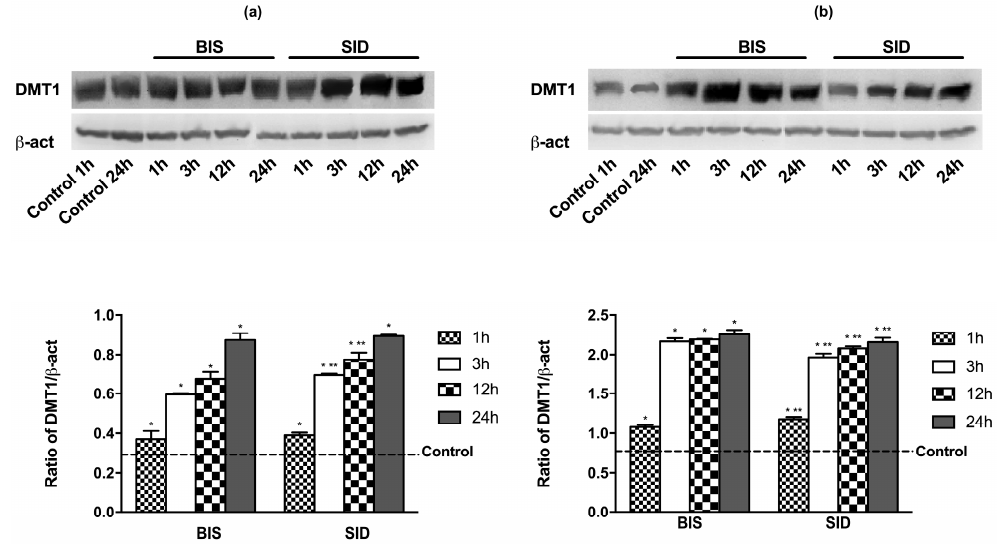
Figure 1. Time-course study (from 1 h to 24 h) of divalent metal transporter 1 (DMT1) receptor in GTL-16 ( a ) and Caco-2 cells ( b ) treated with different iron formulations. Western blot (upper) and densitometric analysis (down) normalized through β -act are reported. The results are expressed as means ± standard deviation (SD) of four independent experiments for each cell type. The control line shows the average of all control measures recorded at different times. BIS = iron bisglycinate; SID = Sideral ® . * p < 0.05 vs. control (reported as line); ** p < 0.05 vs. correspondent column at different times.